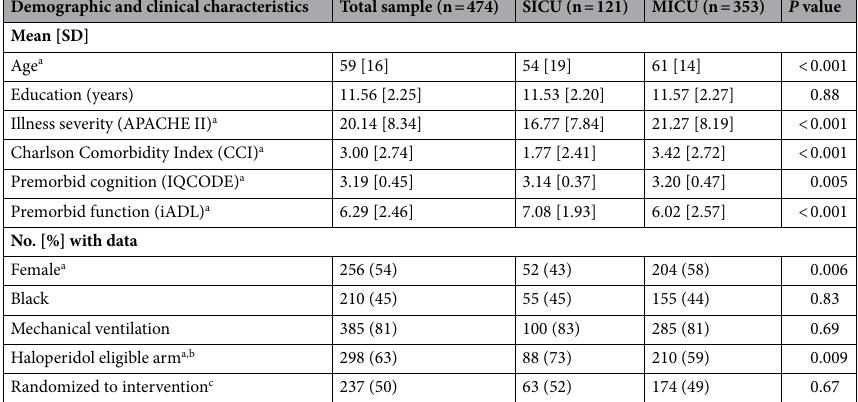
Table 1. Baseline demographic and clinical characteristics. This table presents the study demographics and clinical characteristics of the overall cohort and in each ICU setting. APACHE II illness severity, IADL instrumental activities of daily living (Lawton), ADL activities of daily living (Katz), SICU surgical intensive care unit, MICU medical intensive care unit, CCI Charlson Comorbidity Index, IQCODE informant questionnaire on cognitive decline in the elderly. a Statistically significant differences between MICU and SICU. b Haloperidol Eligible Arm refers to the patients without contraindications to the haloperidol intervention for the PMD study. c Randomized to Intervention refers to the patients assigned to either haloperidol prescribing arm or the de-prescribing only arm of the PMD and de-PMD studies, respectively, as opposed to usual care.